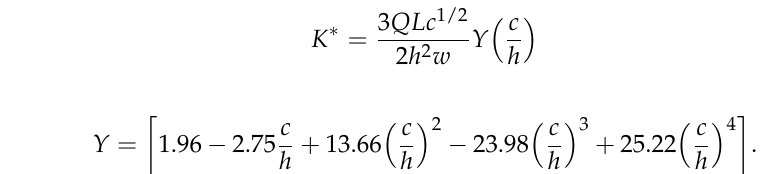
Figure 5. Typical load/displacement curves for composites with composite fibres. The fibre